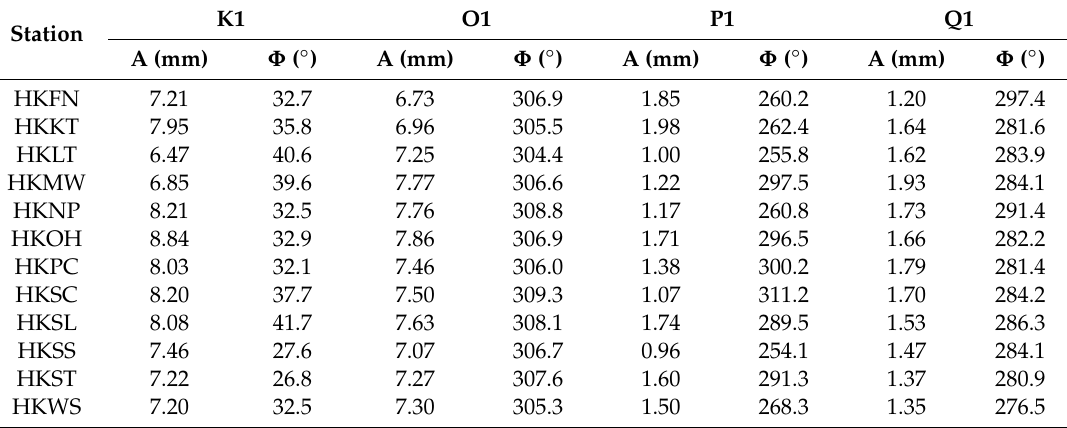
Table A2. KPPP-estimated vertical OTL displacements of four diurnal